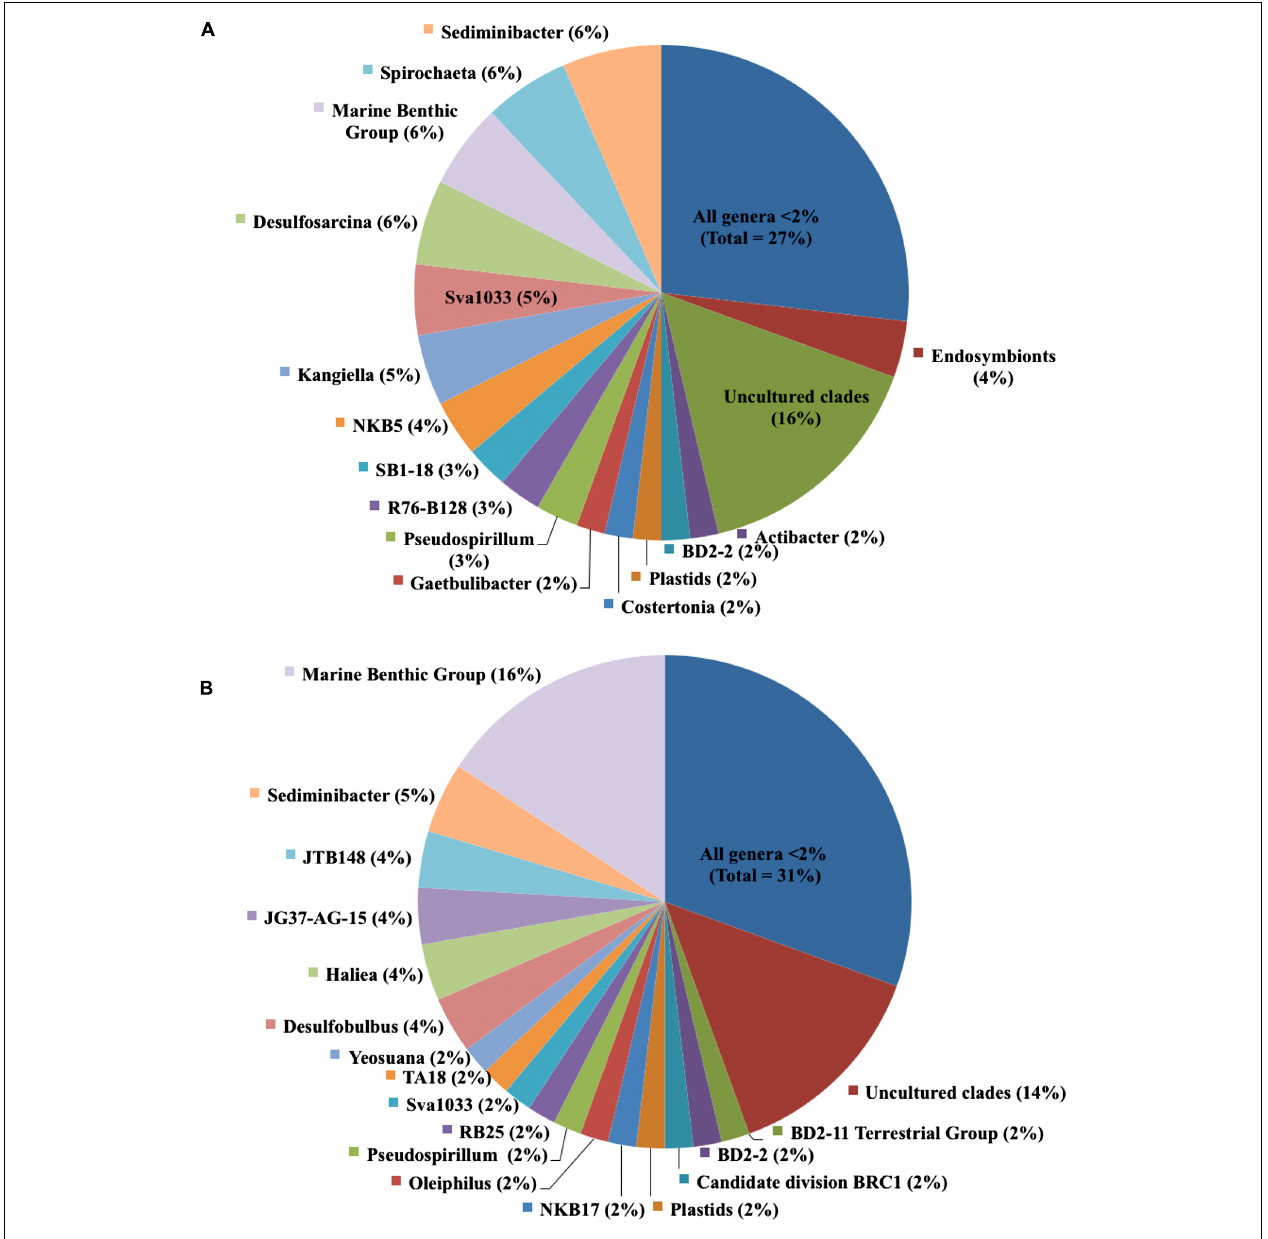
FIGURE 3 | Relative contributions of genera in (A) lignocellulose-responsive bacterial community and (B) non-responsive bacterial community. Cultured genera and uncultured lineages that comprised less than 2% of clones, respectively, were separately grouped.